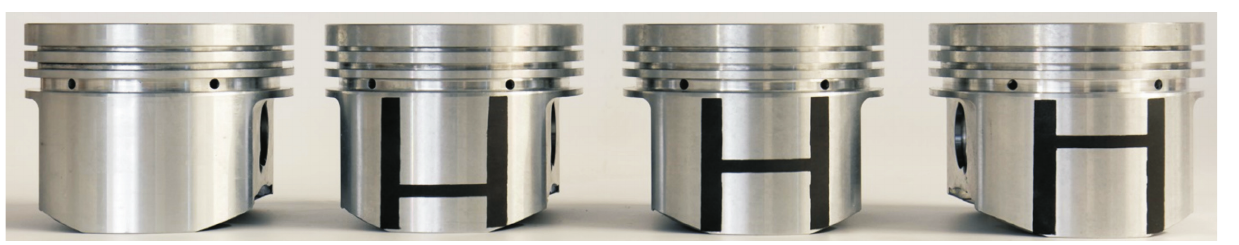
Fig. 1. View of different piston variants